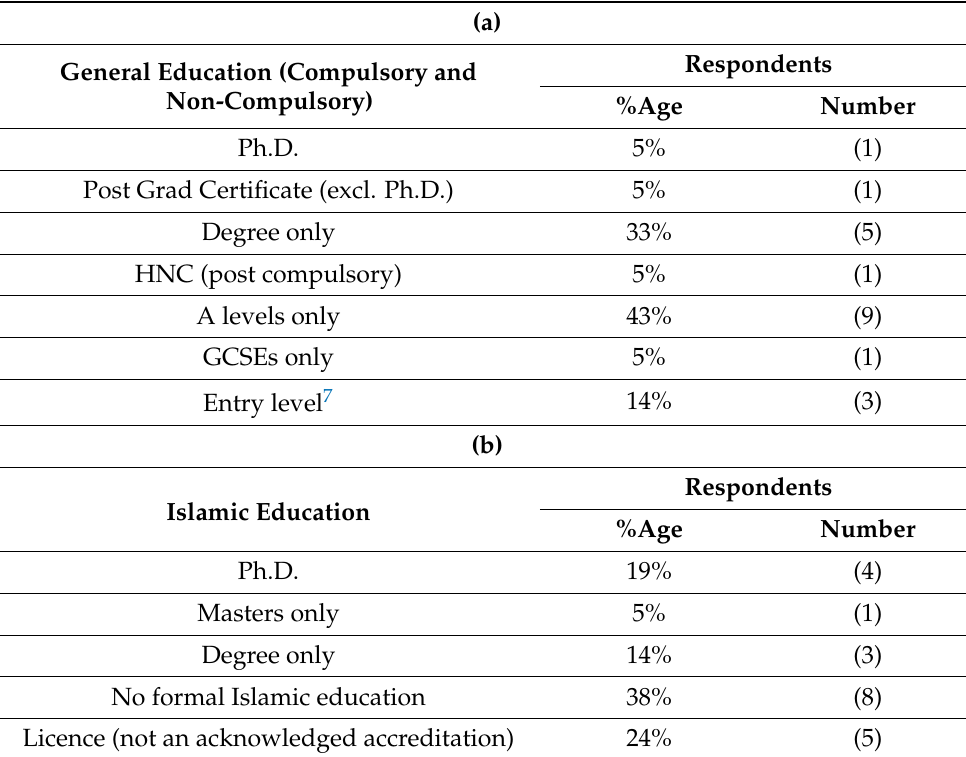
Table 4. ( a ) General education. ( b ) Islamic education of Imam